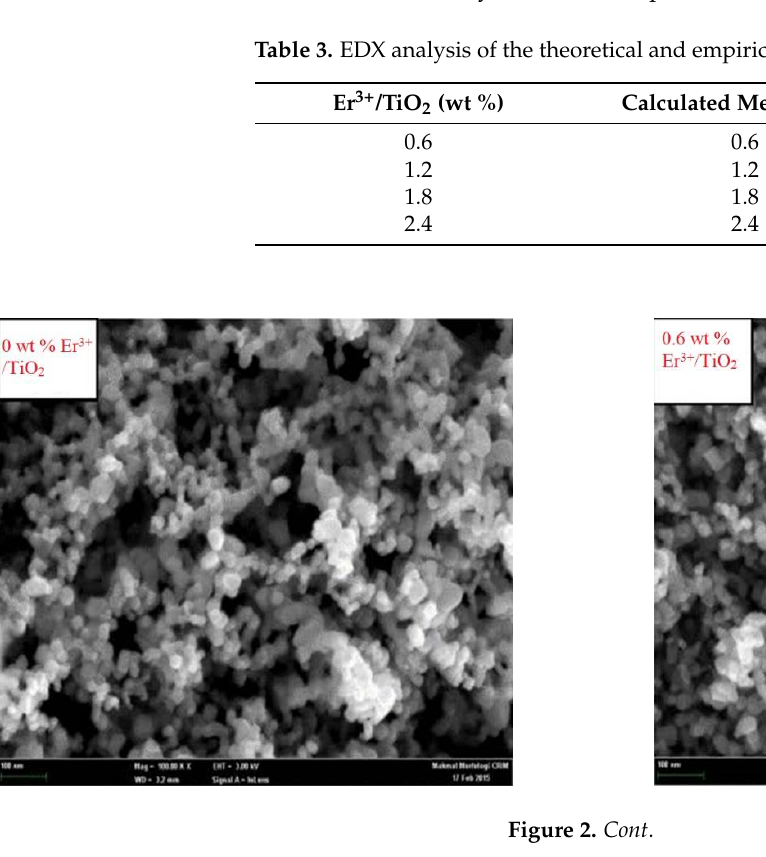
Table 2. Size of crystallite particles of all synthesized samples